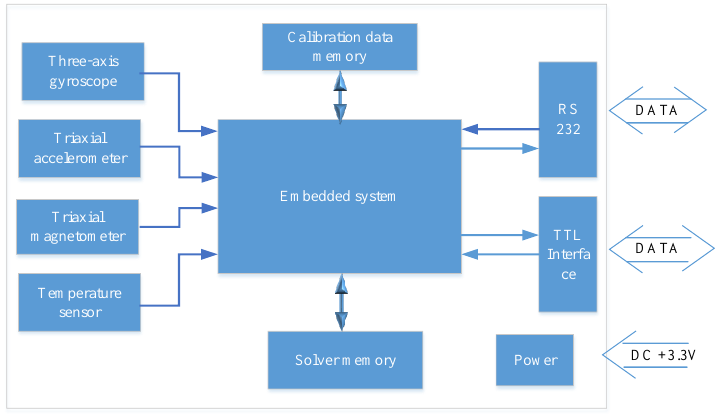
Figure 6. Azimuth sensor block diagram.